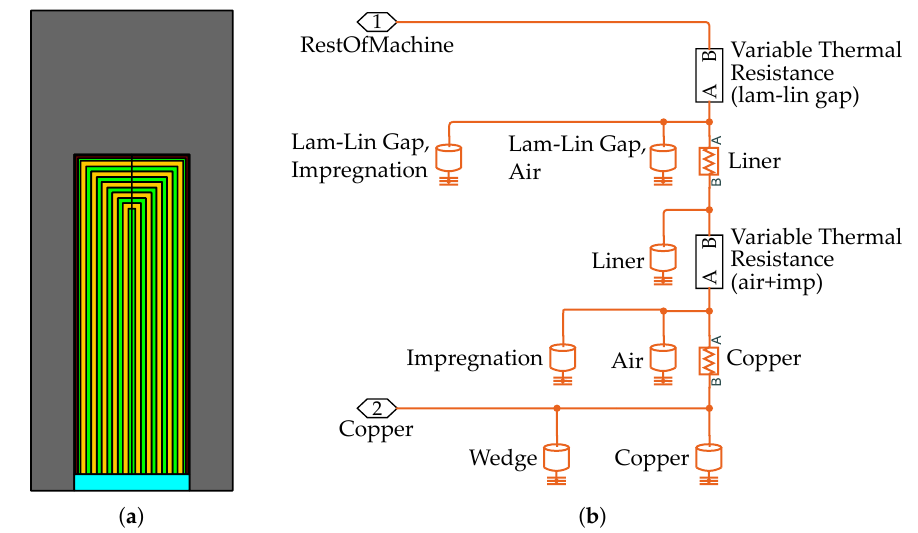
Figure 3. ( a ) Implemented layered winding model. Primary core (gray), copper layers (yellow), air+impregnation layers (green), slot liner (maroon), and wedge (blue). ( b ) Thermal network of the